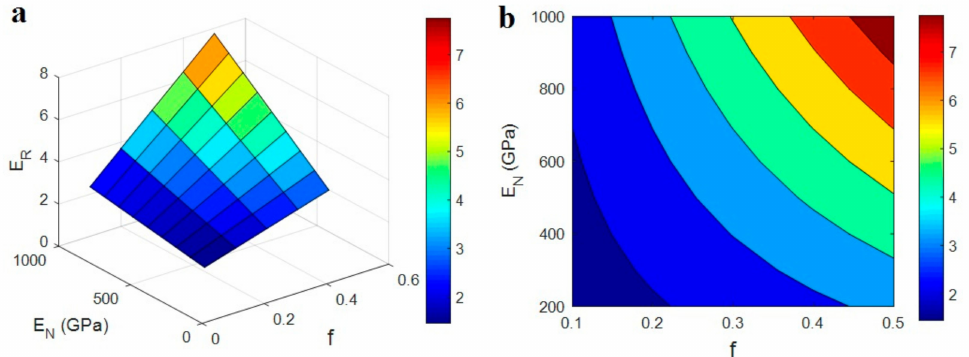
Figure 3. The e ff ects of “ f ” and “ E N ” parameters on the relative modulus (Equation (11)): ( a ) 3D and ( b ) contour